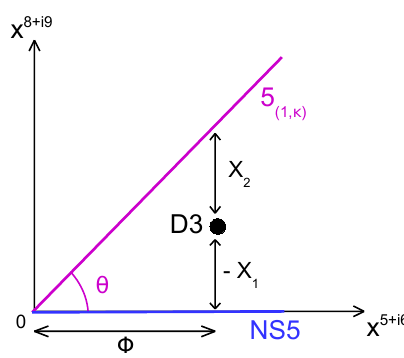
Figure 32 . In the (complexi(cid:12)ed) plane x 5+ i 6 (cid:0) x 8+ i 9 the reconnected D3 brane is a point. We read the constraint X 2 (cid:0) X 1 = tan (cid:18) (cid:8) = (cid:20) (cid:8) on the geometric branch.